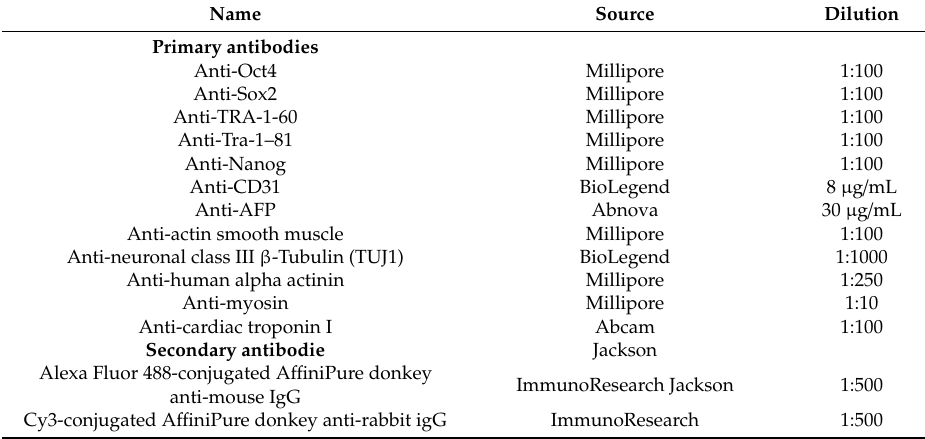
Table 2. Lineage marker-specific